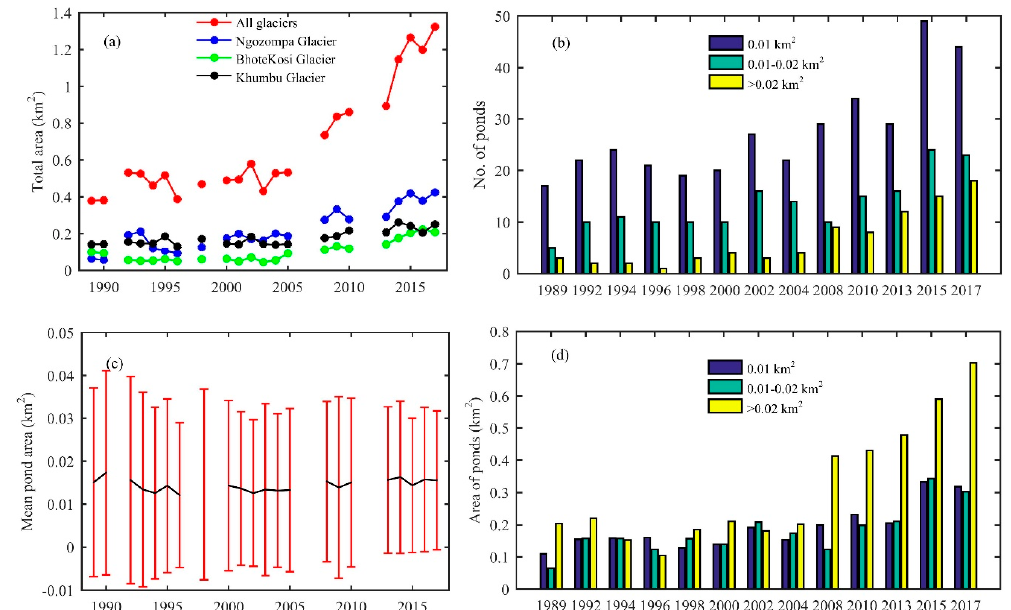
Figure 6. Long-term development of the supraglacial ponds in the Everest region from 1989–2017 ( a ) total ponded area for all study glaciers and three selected glaciers, Ngozompa, Bhote Koshi, and Khumbu glaciers, ( b ) changes in number for three dimensional classes, ( c ) variation in the mean area, and ( d ) changes in the area of three-dimensional classes of supraglacial ponds. Substantial interannual variation in the ponded area was observed due to draining of the ponds within the year. The ponded area on the Ngozompa Glacier increased by approximately 370% from 1990–1993 and then decreased until 1996. This variation in pond area was contributed to by the formation and development of one large pond (0.1 km 2 ) 1.5 km from the current outlet of the glacier. It was almost completely drained (0.007 km 2 ) by 1994. Similarly, a large pond on the Bhote Koshi Glacier also lost its size by 530% within a period of 1–2 years, from 1990–1992 and contributed to a decrease in ponded area on this glacier within this period.